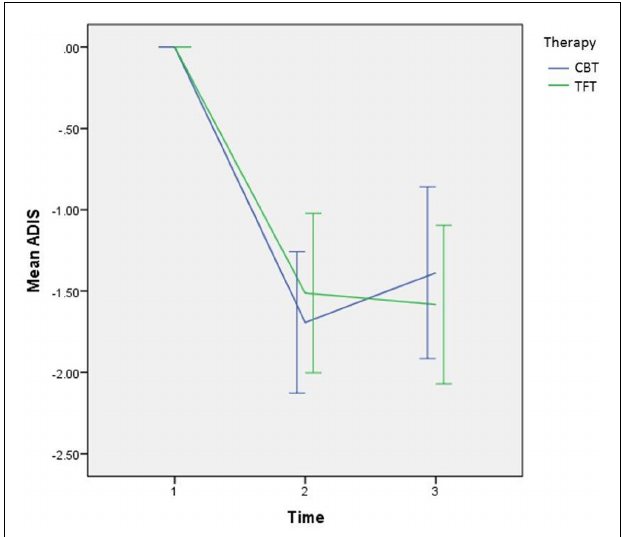
FIGURE 4 | Curves showing mean changes with a 95% CI in the primary effect variable of avoidance from the ADIS, from before to after treatment with CBT ( n = 36) or TFT ( n = 36), and from before to 12 months after